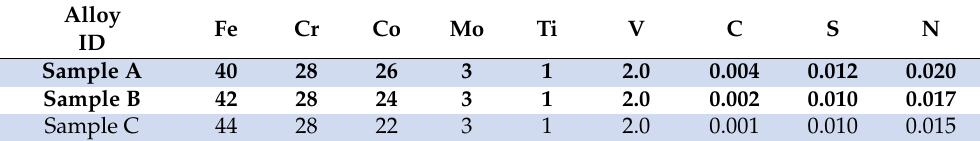
Table 1. Chemical composition analysis of the alloys: Sample A, Sample B and Sample C.